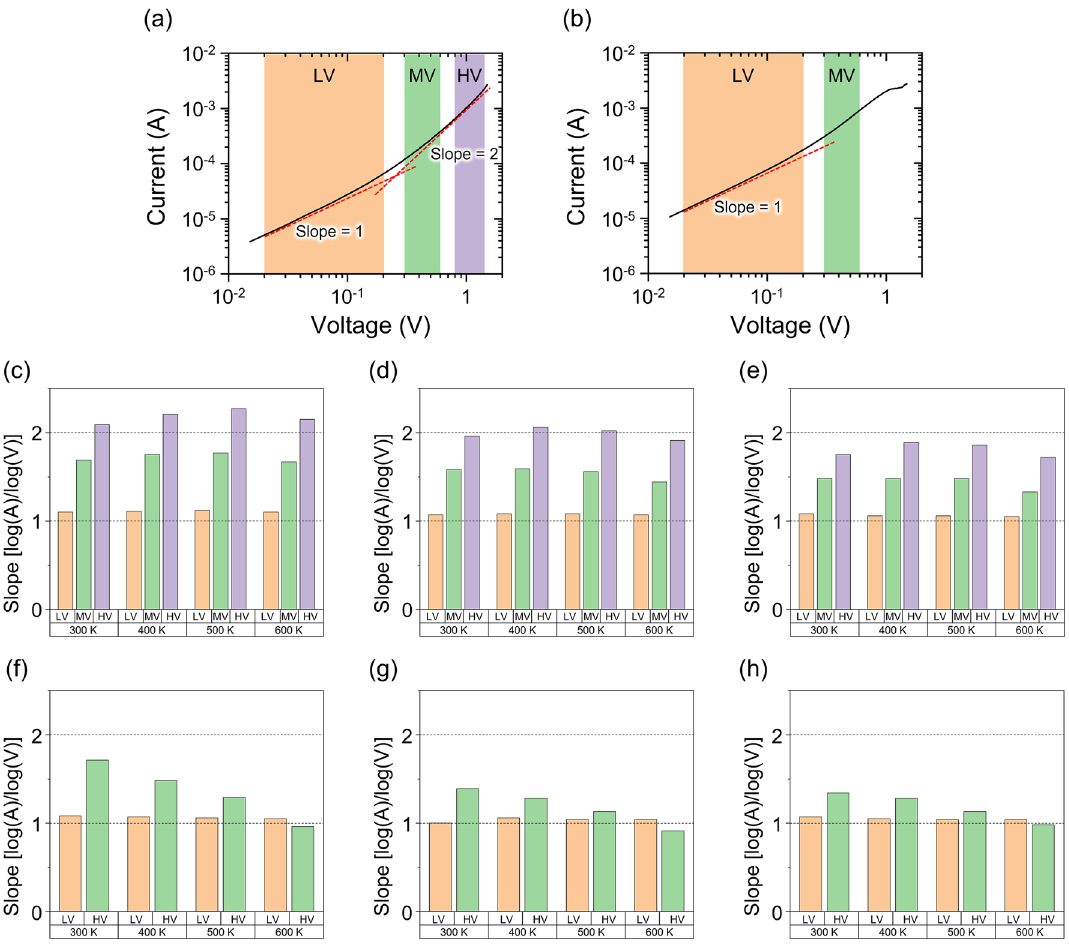
Figure 5. Double logarithmic I–V curves of sample G05 for ( a ) HRS and ( b ) LRS with eye-guiding lines for the slope = 1, 2 [log(A)/log(V)]. Values of the slope at HRS and LRS of Samples ( c , f ) G05, ( d , g ) G10, and ( e , h ) G15 at temperatures of 300–600